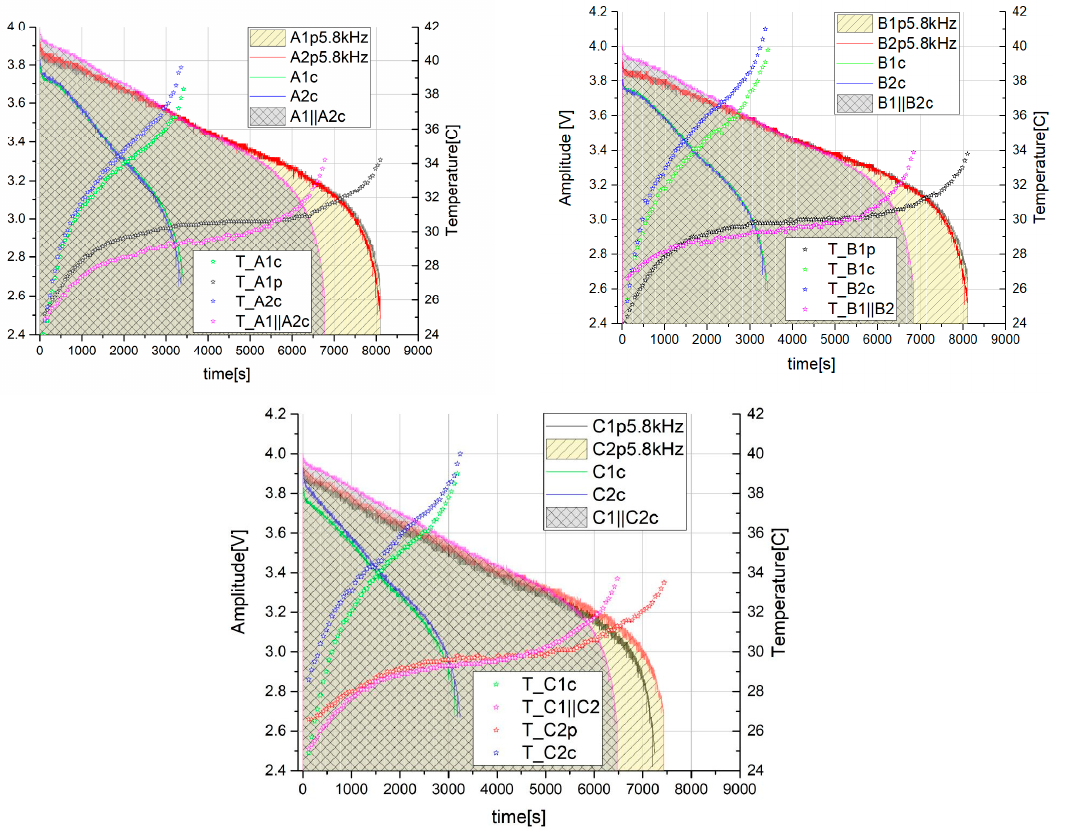
Figure 10. Temperature profiles and discharge curves profiles under continuous (“c”), switched (“p”) and parallel discharge (“||c”) batteries. T: temperature, A1, A2, B1, B2, C1, C2: cells.